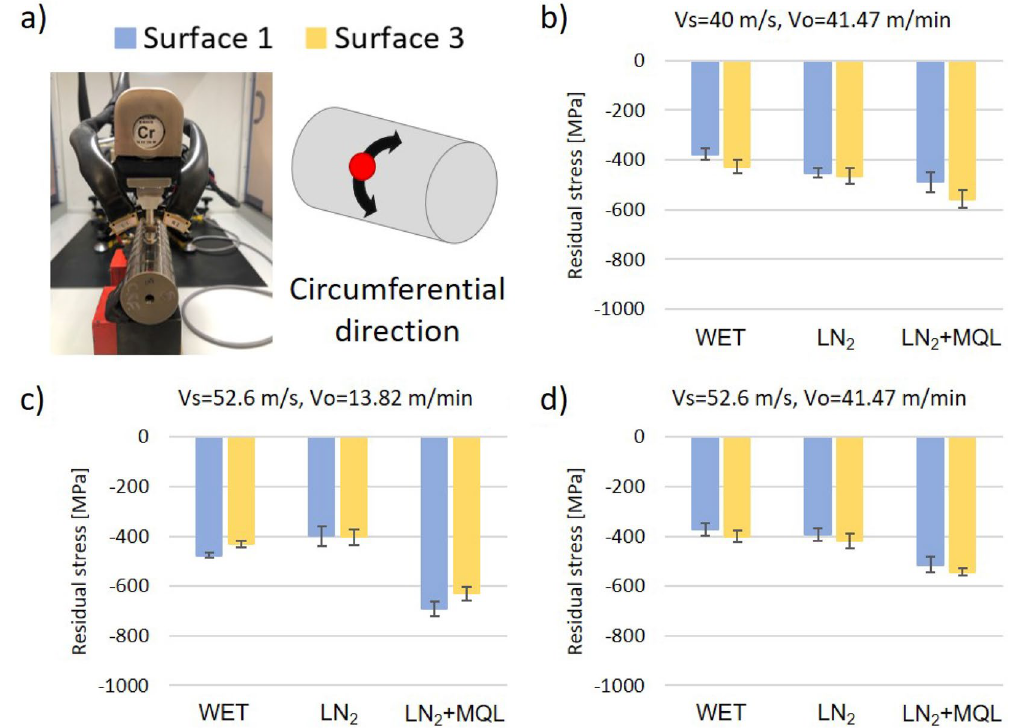
Figure 8. Circumferential residual stress on the first and third ground surfaces with best grinding conditions. ( a ) Scheme of measures, ( b ) Vs = 40 m/s, Vo = 41.47 m/min, ( c ) Vs = 52.6 m/s, Vo = 13.82 m/min, and ( d ) Vs = 52.6 m/s, Vo = 41.47